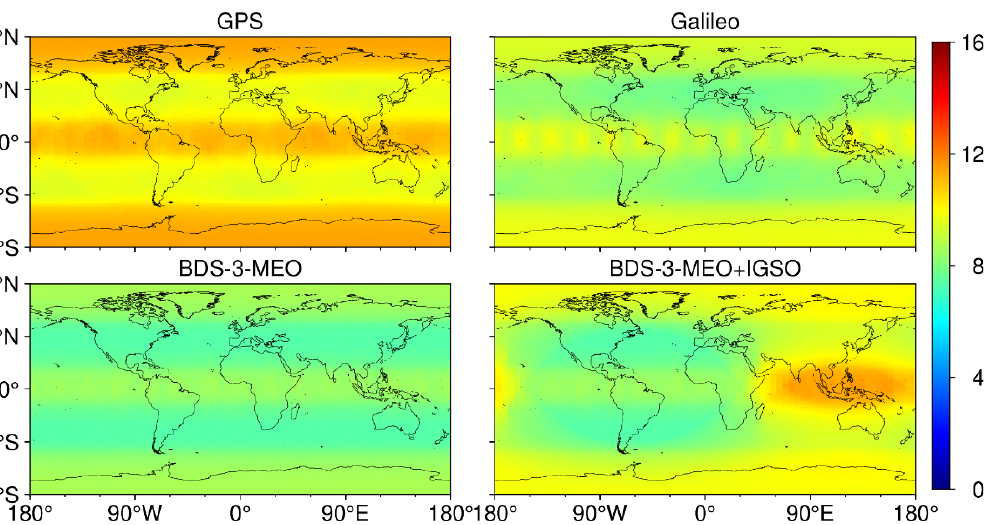
Figure 2. Average visible satellite numbers of GPS, Galileo, BDS-3 MEO, and BDS-3 MEO+IGSO over a day (1 September 2022) with an elevation cut-off of 7°.